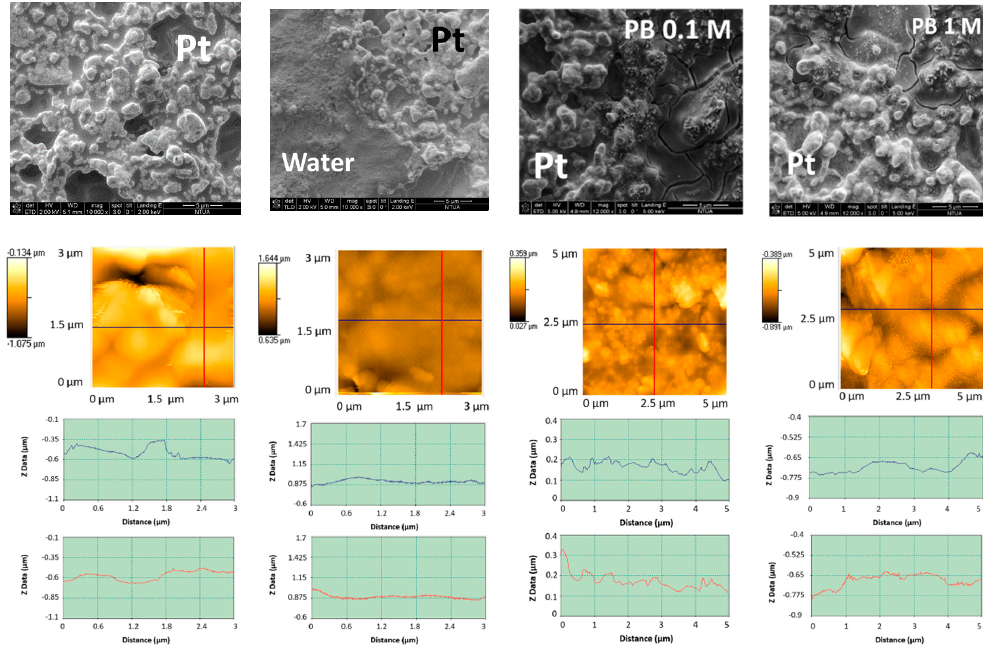
Figure 1. First row: SEM (from left to right) of untreated Pt and LIFT treated with water, phosphate buffer 0.1 M and phosphate buffer 1 M; second row: the corresponding topographic atomic force micrographs; third row: roughness profiles in the two orthogonal directions indicated in the atomic force micrographs.